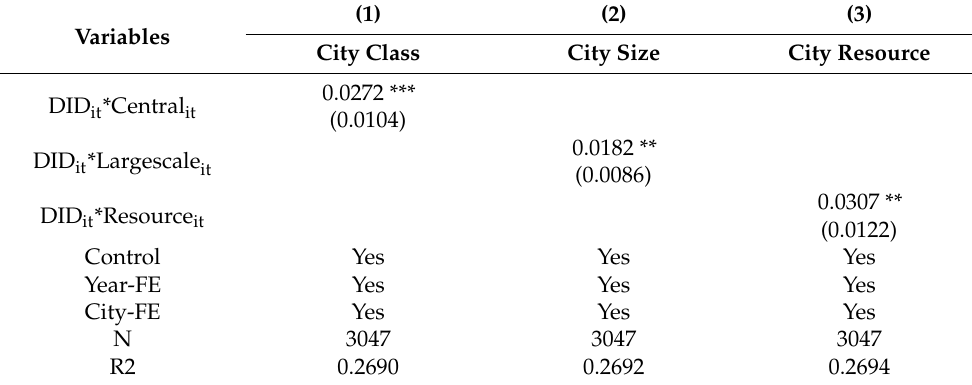
Table 8. Heterogeneity Regression